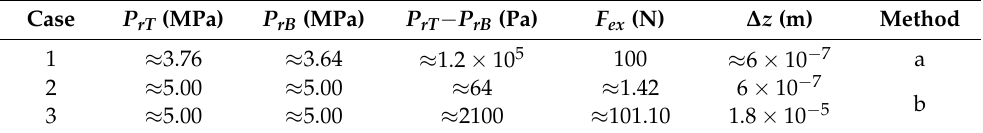
Table 4. Simulation results under loading